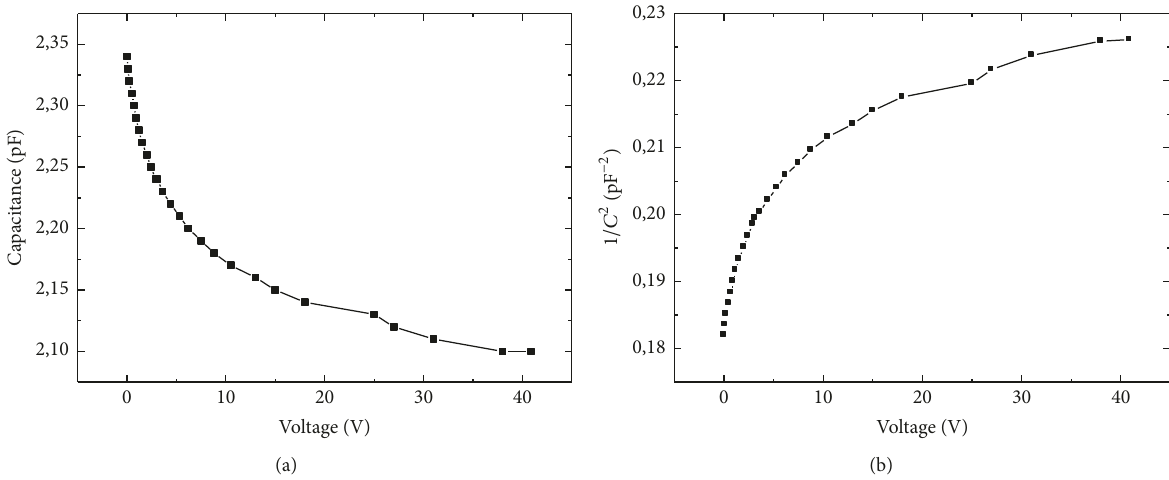
Figure 3: The dependence of capacitance (a) and the value 1/𝐶 2 (b) for one of the diodes under reverse voltages measured at 1MHz.